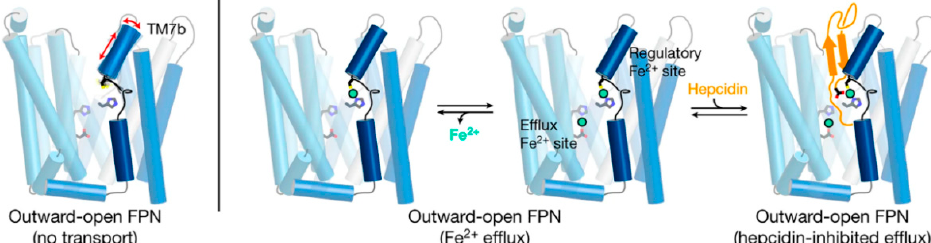
Figure 3. A current model of hepcidin (orange) interaction with ferroportin (blue) in which binding is dependent on iron (green). The framework of helices that make up ferroportin are depicted as cylinders connected by extracellular and intracellular disordered loops. The side chains that make up the binding sites for iron are shown. Modified from [14].